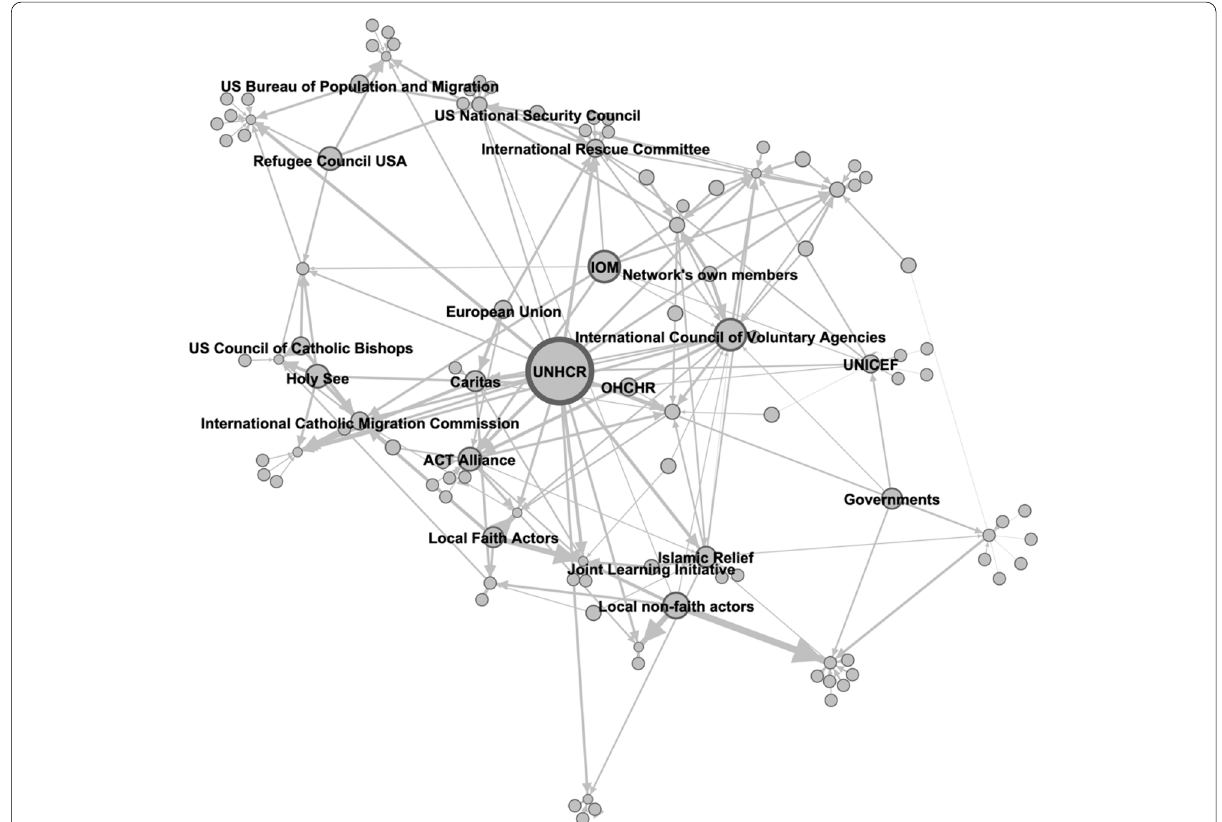
Fig. 1 Policy network showing out‑degree centrality, with node size scaled by out‑degree centrality